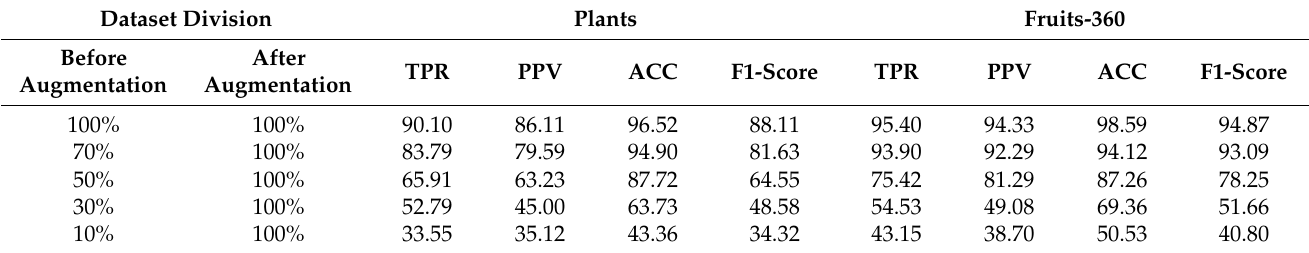
Table 30. Comparison of accuracies achieved by the proposed PI-CNN in the original and PI-GAN- augmented datasets. The accuracies were achieved in the Plants and Fruits-360 datasets (unit: